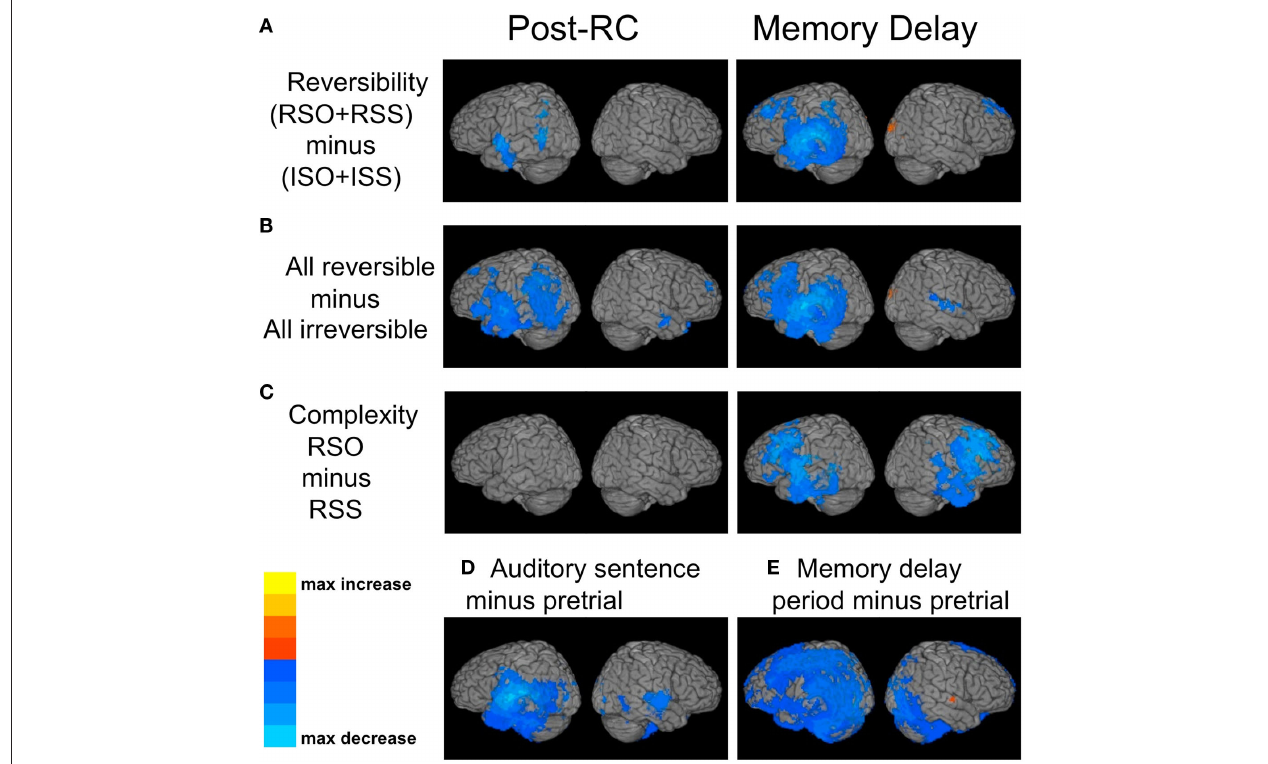
FiguRE 4 | Synthetic aperture magnetometry maps of power changes in the 8–30 Hz frequency range. (A) Power changes following the relative clause for reversible vs. irreversible sentences, during the post-RC portion of the sentence (left panel), and during the post-sentence memory delay (right panel). (B) Same as part (A) , except that the simple active conditions are also included in the comparison, not just the sentences containing relative clauses. (C)